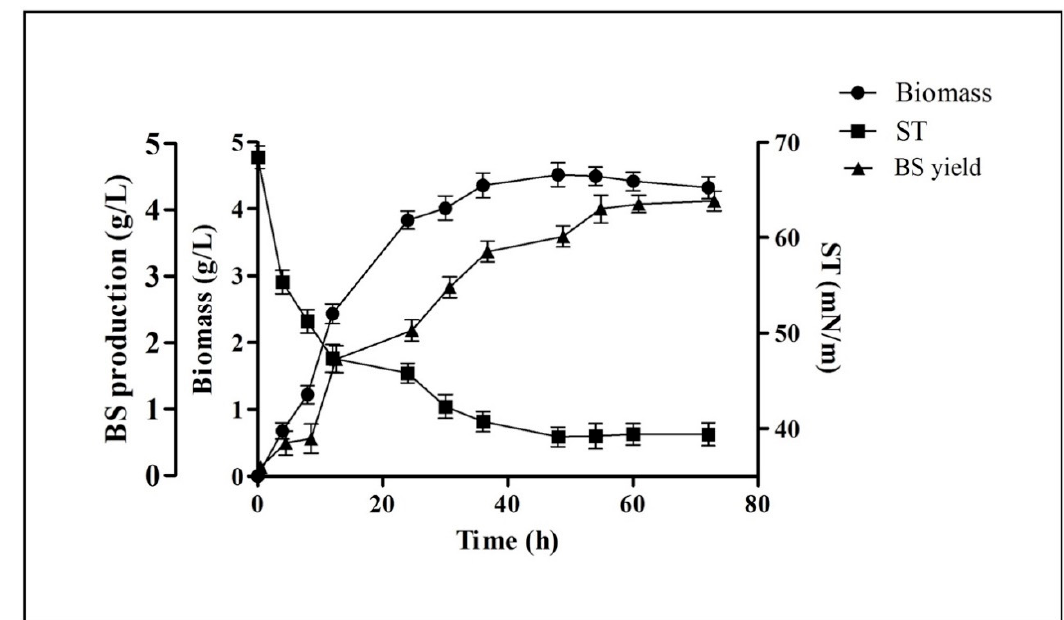
Figure 2. Profiling of growth kinetics of P. pentosaceus in reference to the reduction in surface tension (ST) and production the biosurfactant (BS) at different time intervals. Values are represented as mean ± SD of three independent experiments.